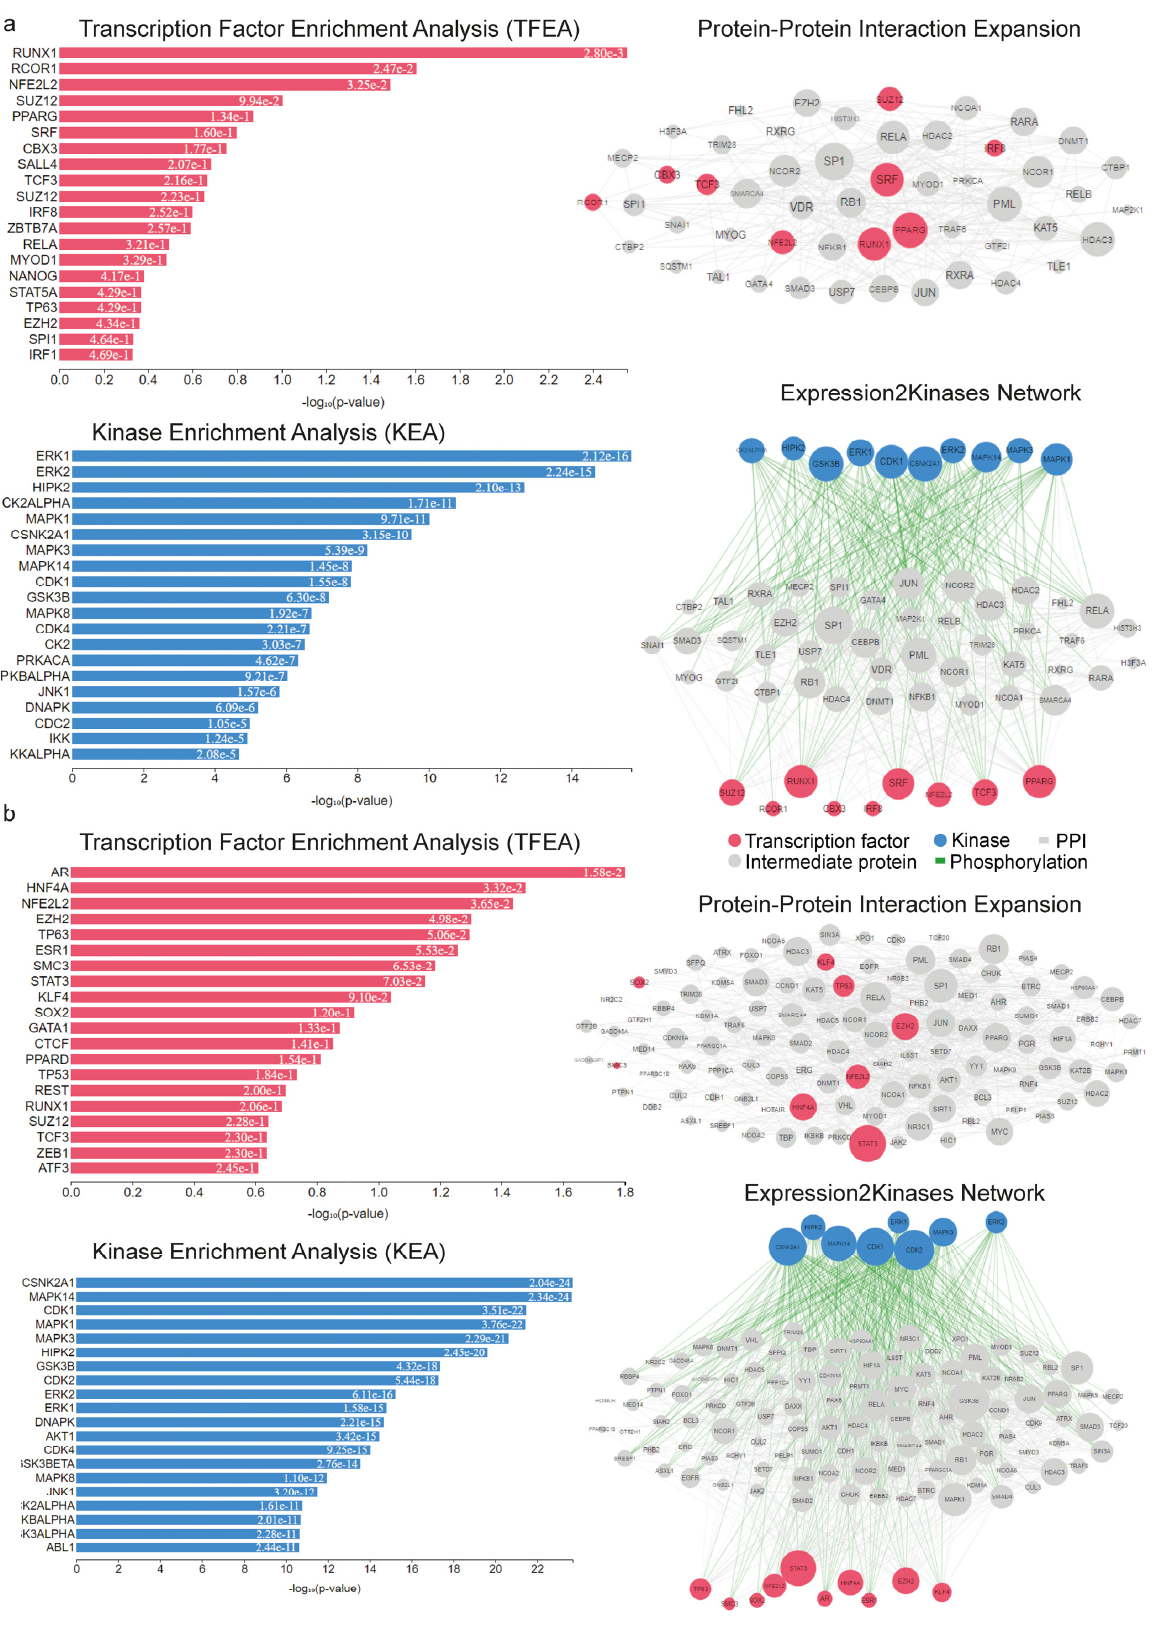
Figure 6. Upstream regulatory networks for the up- ( a ) and downregulated ( b ) genes in pediatric RUNX1/RUNX1T1 AML patients (GSE75461